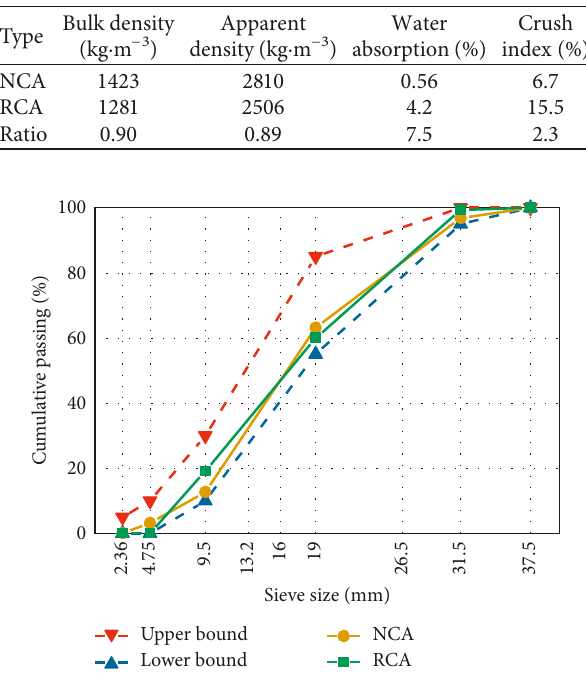
Table 1: Main physical properties of the coarse aggregate.